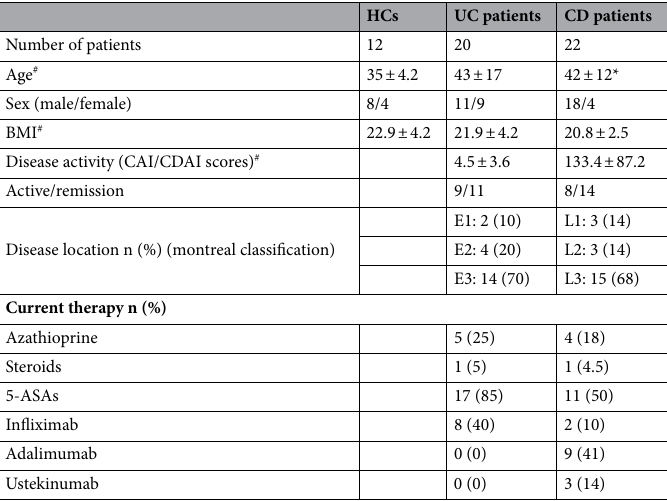
Table 1. Characteristics of patients with IBD and healthy controls. HC Healthy control, UC ulcerative colitis, CD Crohn’s disease, SD standard deviation, CAI Clinical Activity Index, CDAI Crohn’s disease activity. * p < 0.05 (vs HCs), # mean ±